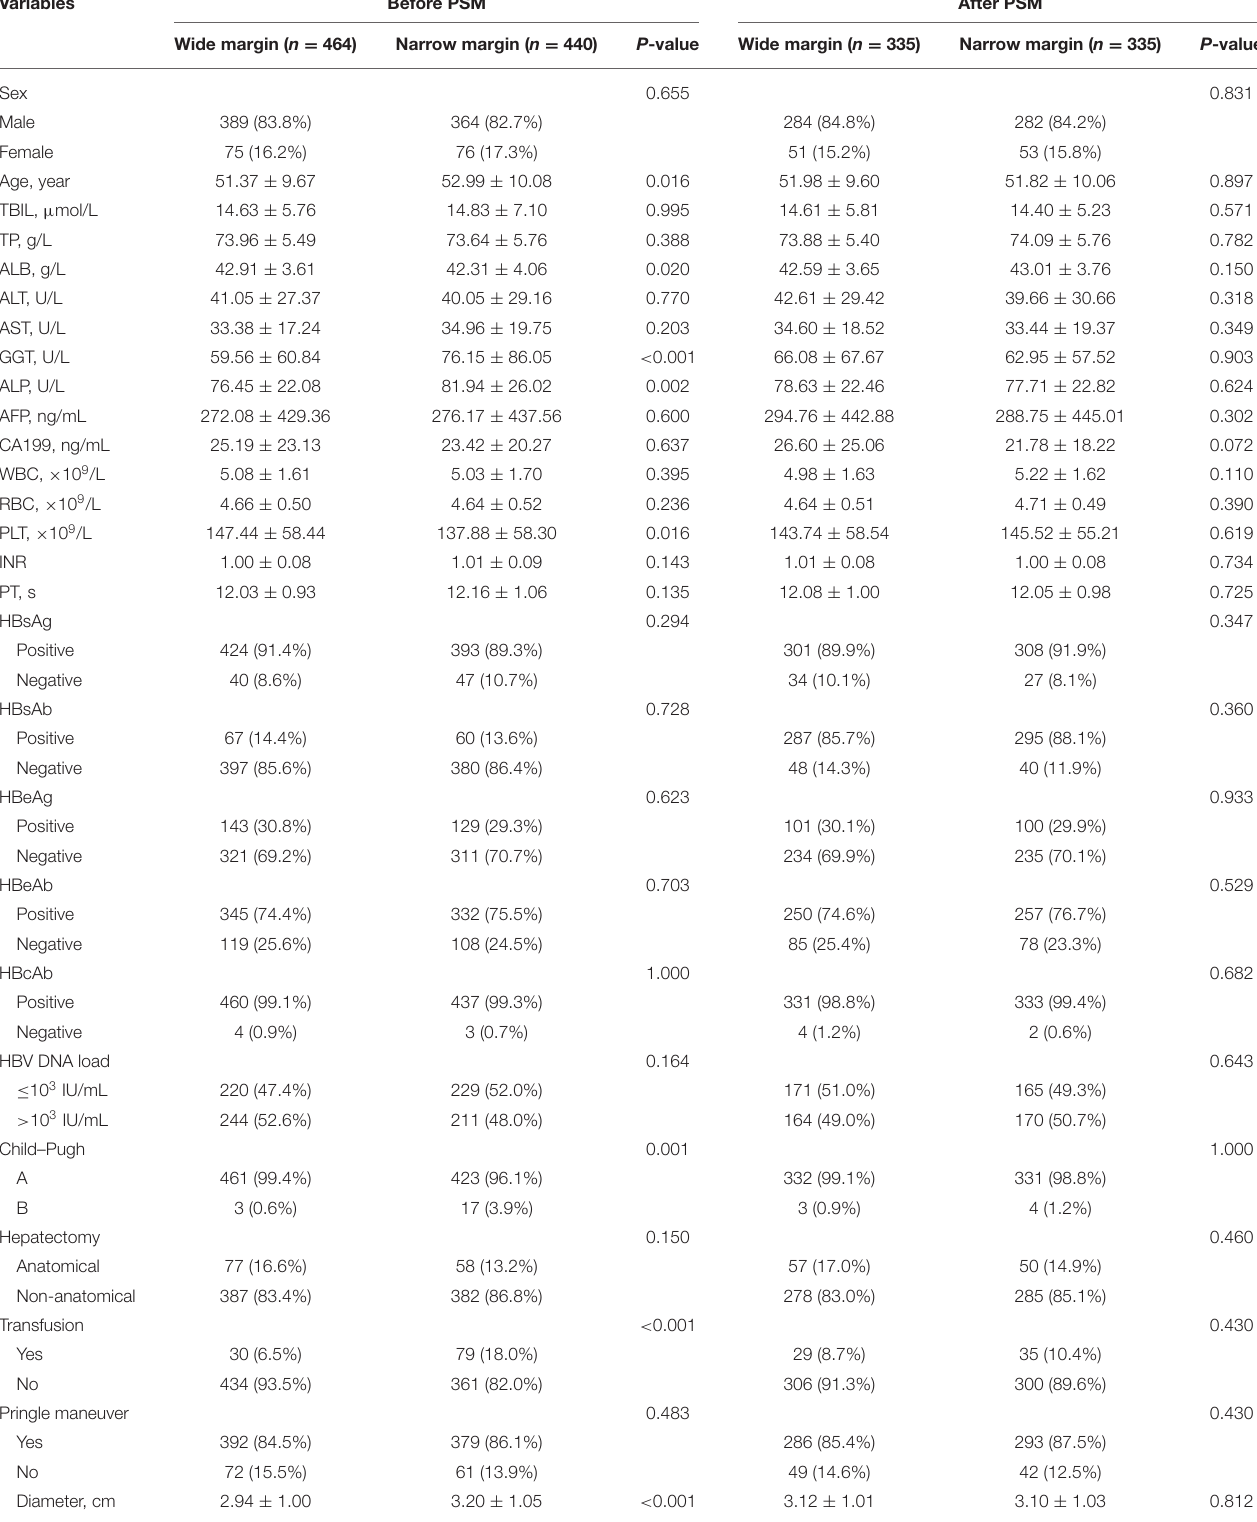
TABLE 1 | Baseline clinicopathological characteristics of